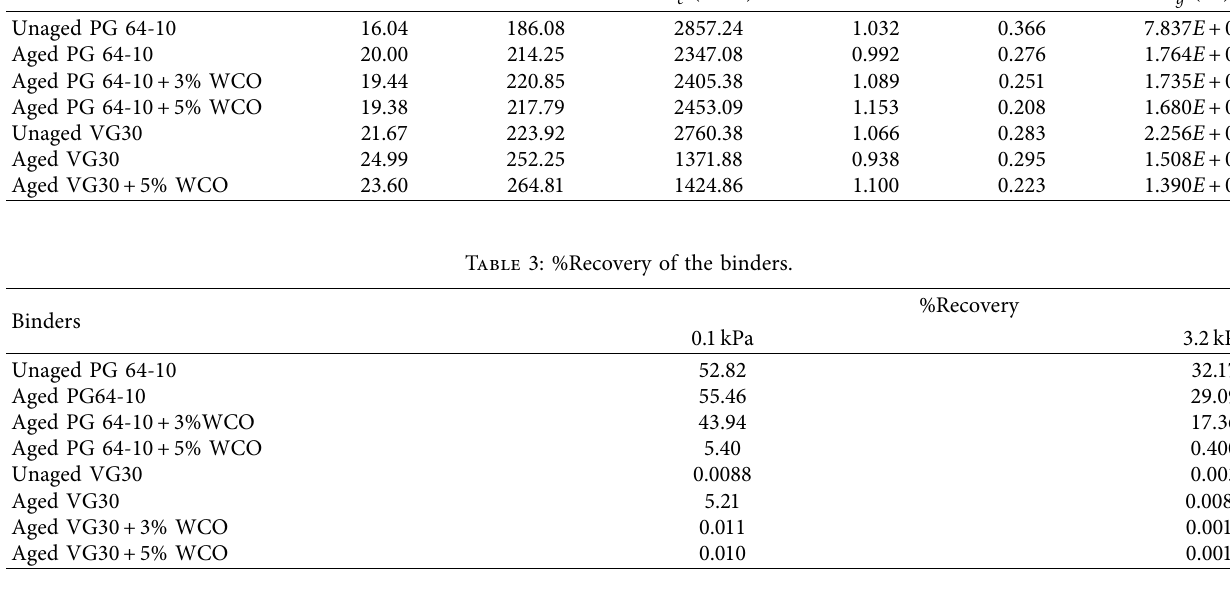
Table 4: Burger’s model parameters for PG 64-10.